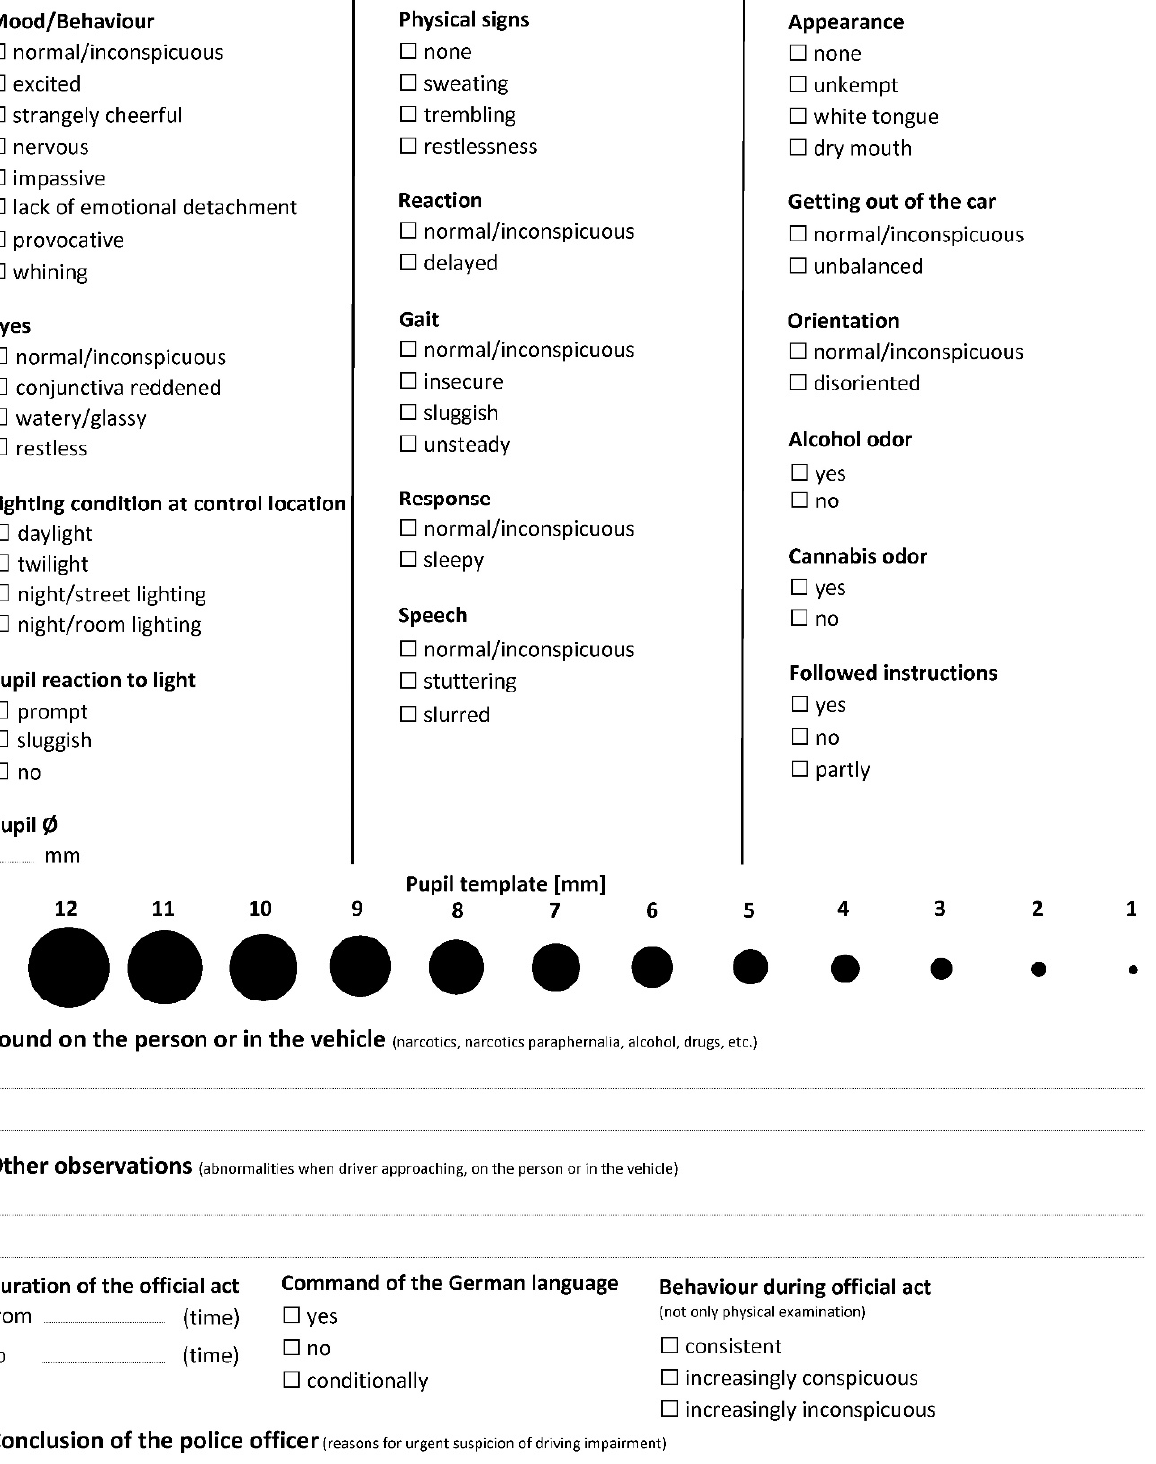
Figure 4. The redesigned checklist.